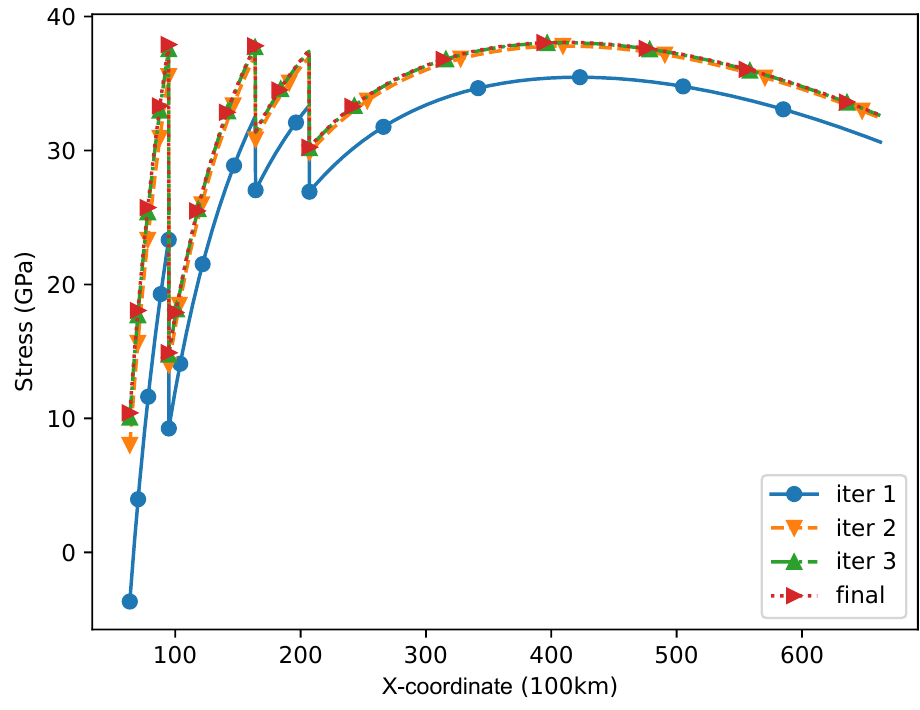
Figure 10. Stress distribution diagram of segment section space elevator system.